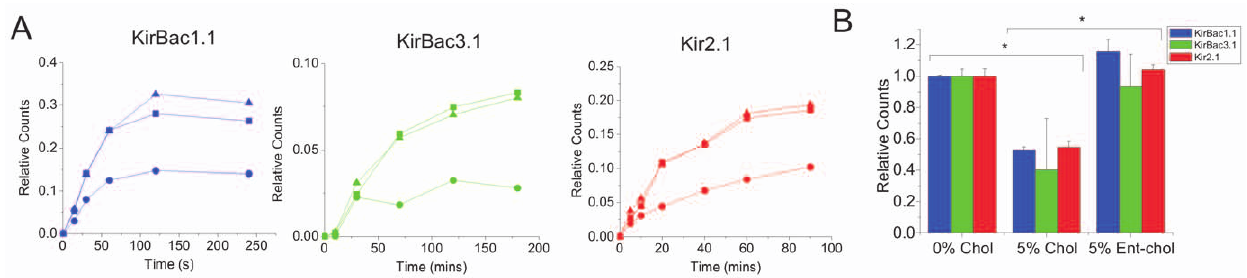
N ) or 5% ent- cholesterol ( m ) reconstituted